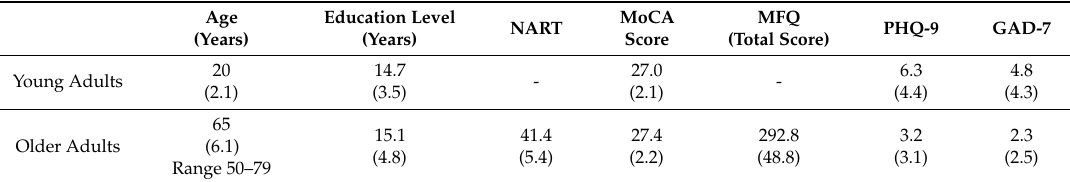
Table 1. Baseline group mean demographics for the younger and older adult groups. Standard deviation in